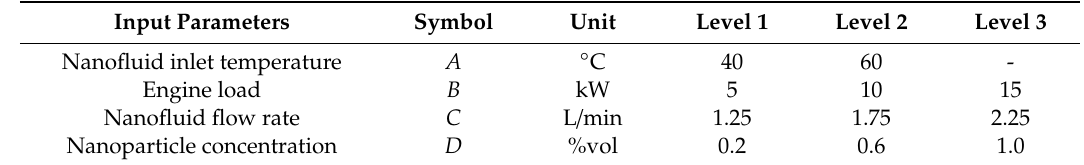
Table 2. Input parameters and their